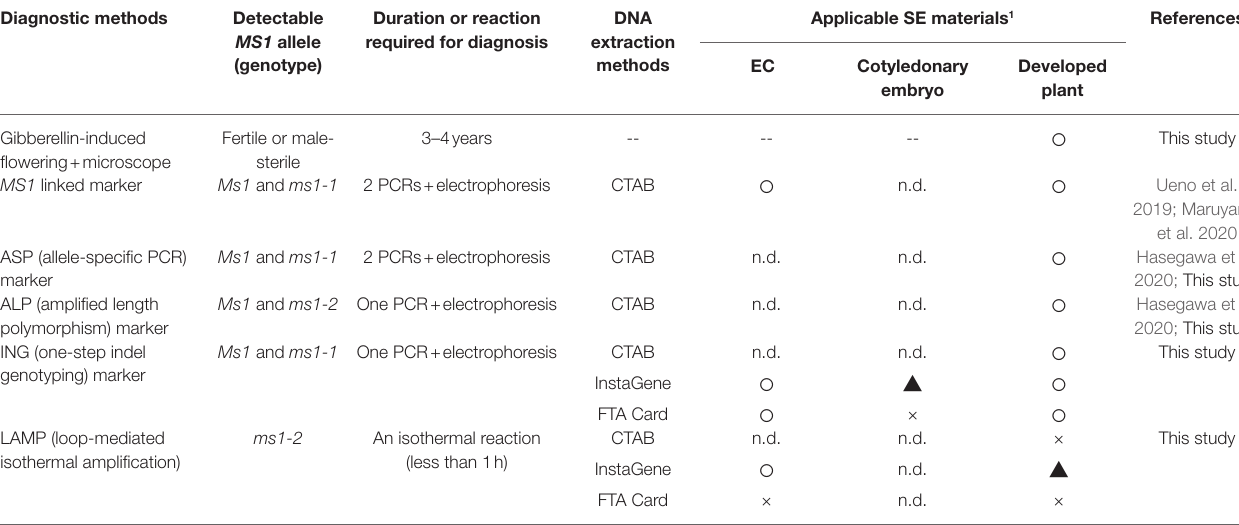
TABLE 4 | MSP diagnosis methods used in this study and applicable SE